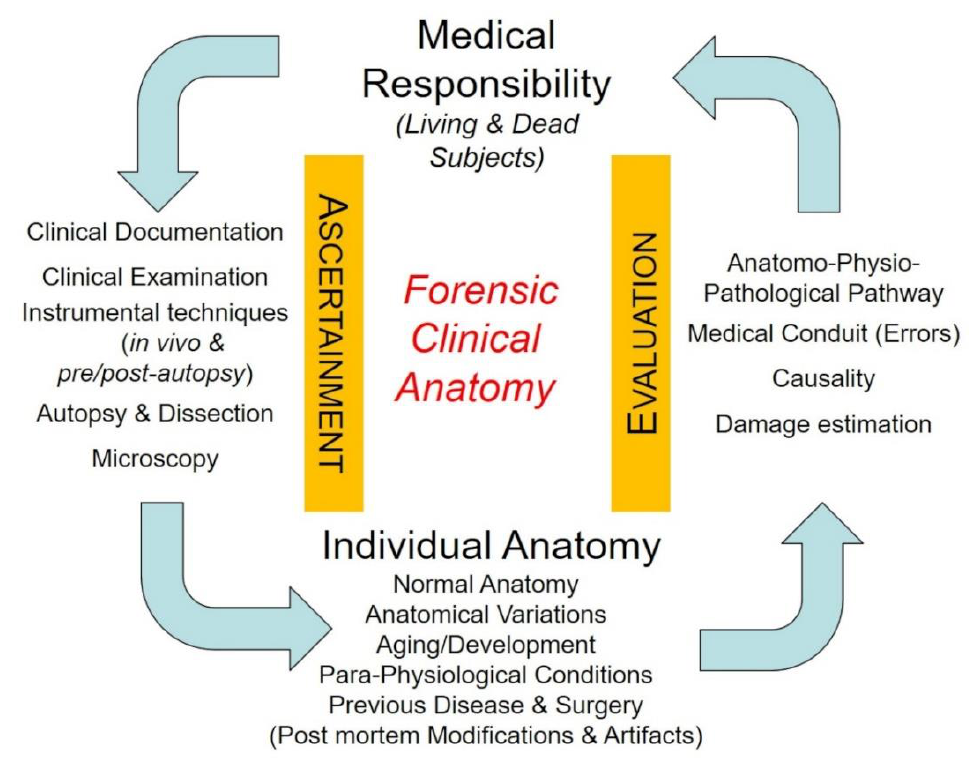
Figure 1. Forensic clinical anatomy and medical malpractice hypotheses. The individuality of anatomy is derived from ascertainment methods and must be considered in the evaluation phase for final judgement on medical responsibility/liability.